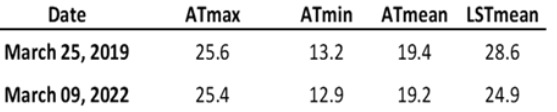
Table 1. Air temperature values recorded in PAGASA Baguio Station and LST values during March 2019 and March 2022.